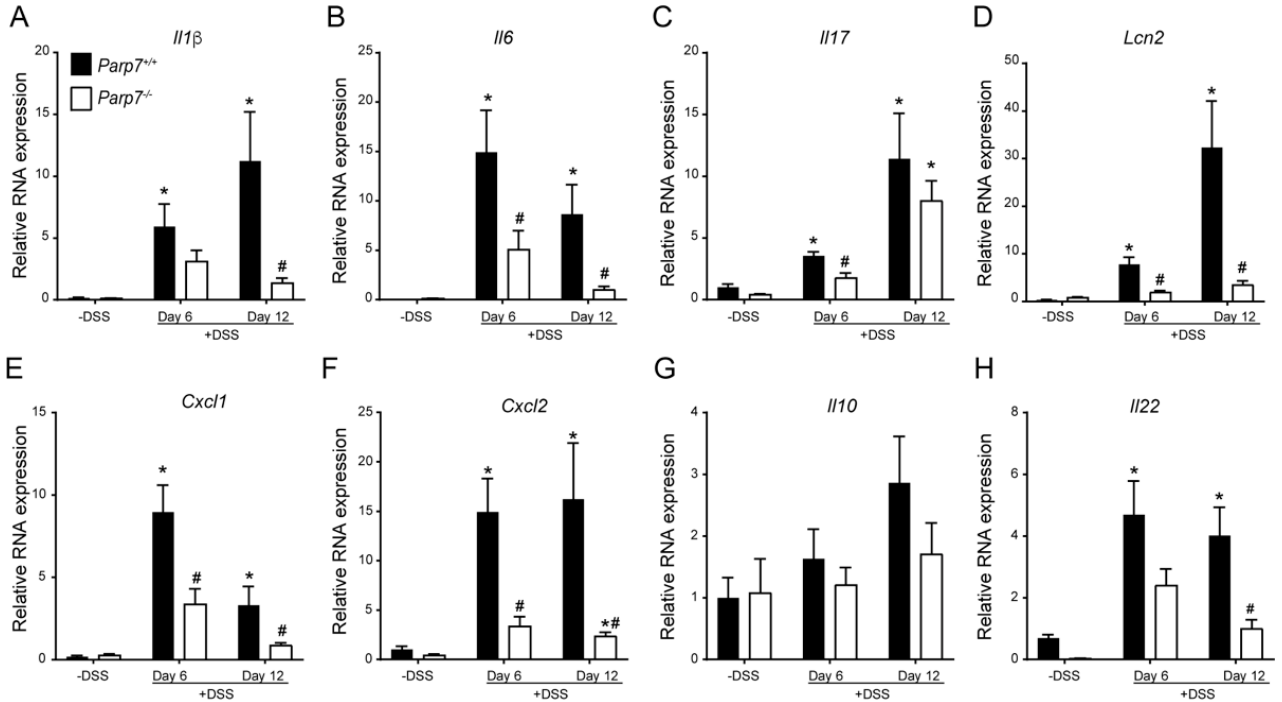
Figure 4. Lower expression of proinflammatory genes is observed in DSS-exposed Parp7 − / − mice. Intestinal mRNA expression levels of ( A ) Il1 β , ( B ) Il6 , ( C ) Il17 , ( D ) Lcn2 , ( E ) Cxcl1 , ( F ) Cxcl2 , ( G ) Il10 , and ( H ) Il22 in colon tissue isolated from Parp7 +/+ and Parp7 − / − mice that were not exposed to DSS (- DSS) or exposed to 2% DSS in their drinking water for 6 days or 12 days (6 days DSS followed by 6 days water). The relative mRNA levels of the indicated genes were determined with RT-qPCR. * p < 0.05 two-way ANOVA compared with genotyped-matched and DSS treated animals. # p < 0.05 two-way ANOVA compared with time matched Parp7 +/+ mice.